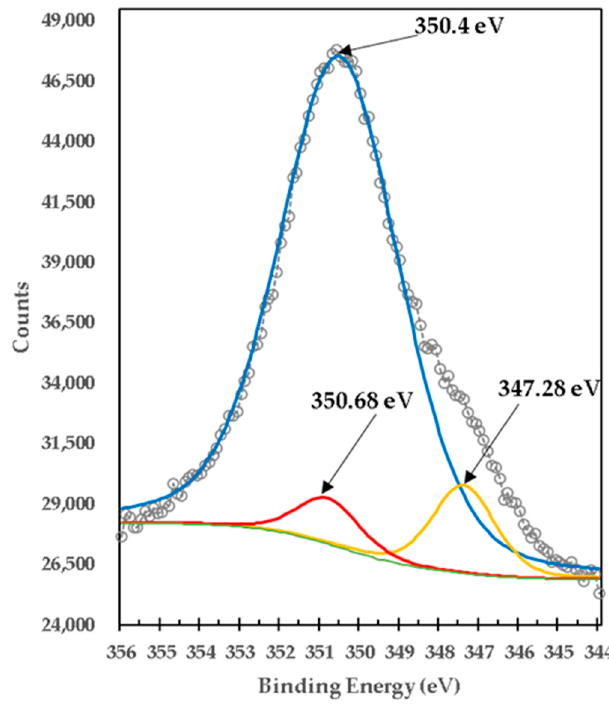
Figure 11. XPS high-resolution spectrum of Ca2p in titania mixed with brucite and calcined at 1100 °C for 1 h M1.